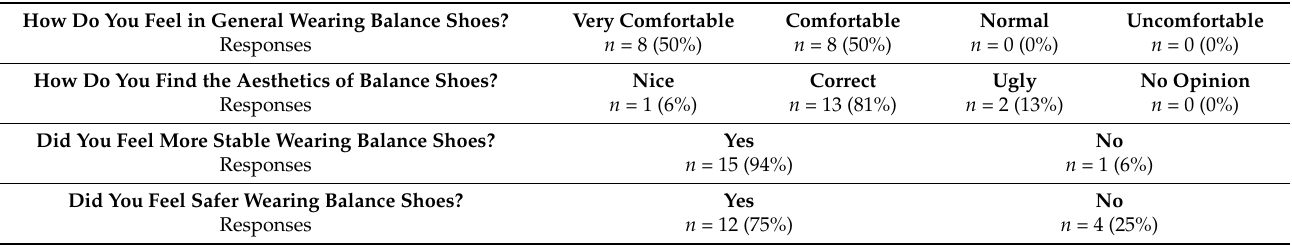
Table 4. Subjective perception of balance